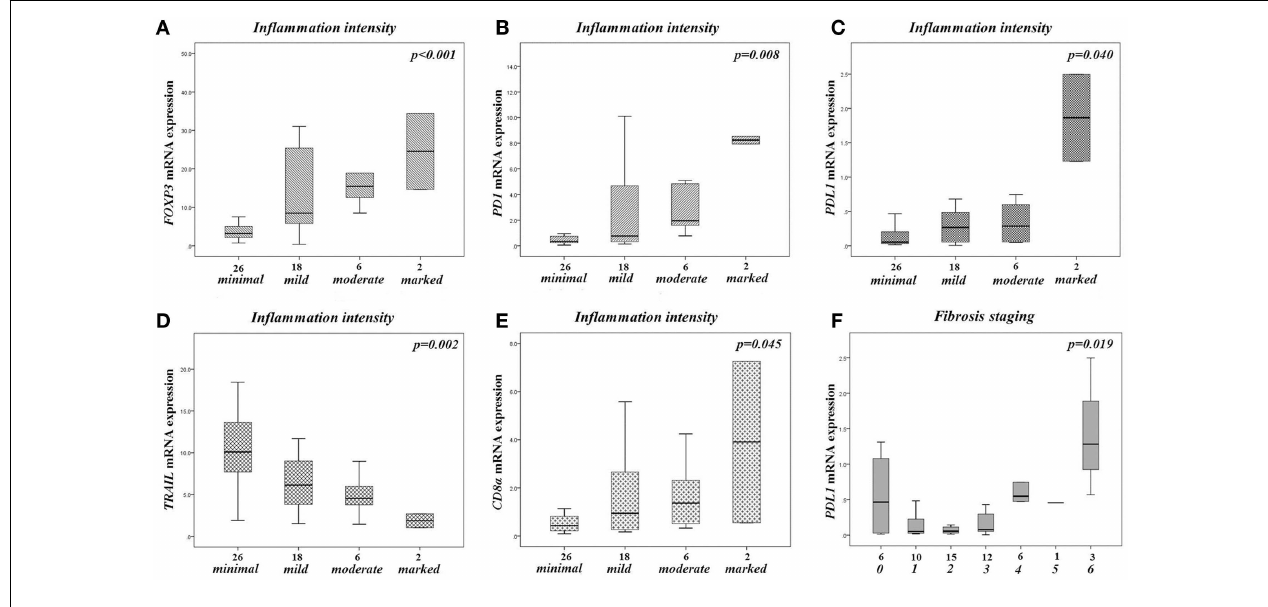
fibrosis (classification as presented in Materials and Methods ).The boxes represent the interquartile range, which contains the 50% of values.The whiskers are lines that extend from the box to the highest and lowest values, excluding outliers. A line across the box indicates the median value for each patient cohort. p -Values in each diagram refers to Kruskal–Wallis H